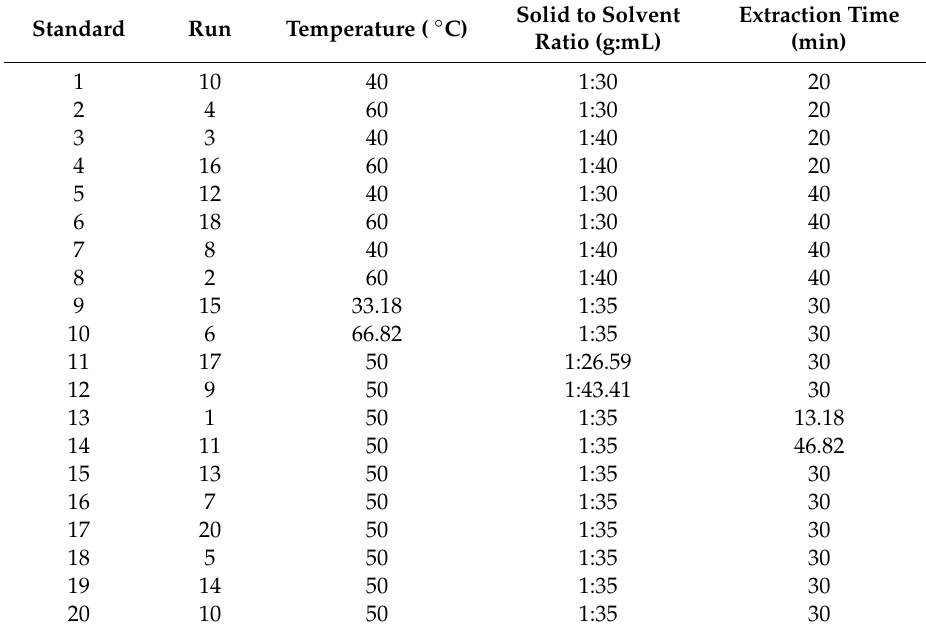
Table 2. CCD for the ultrasound-assisted extraction (UAE) of thymol